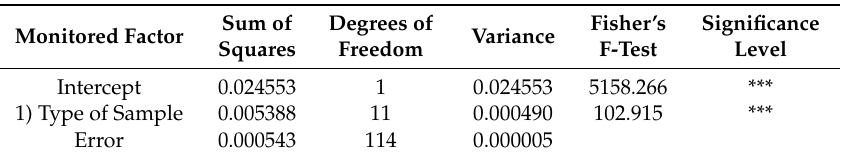
Table 10. Statistical evaluation of the e ff ect of the factors and their interaction on the coe ffi cient of wood bendability ( K bendB ) for beech and NWC on